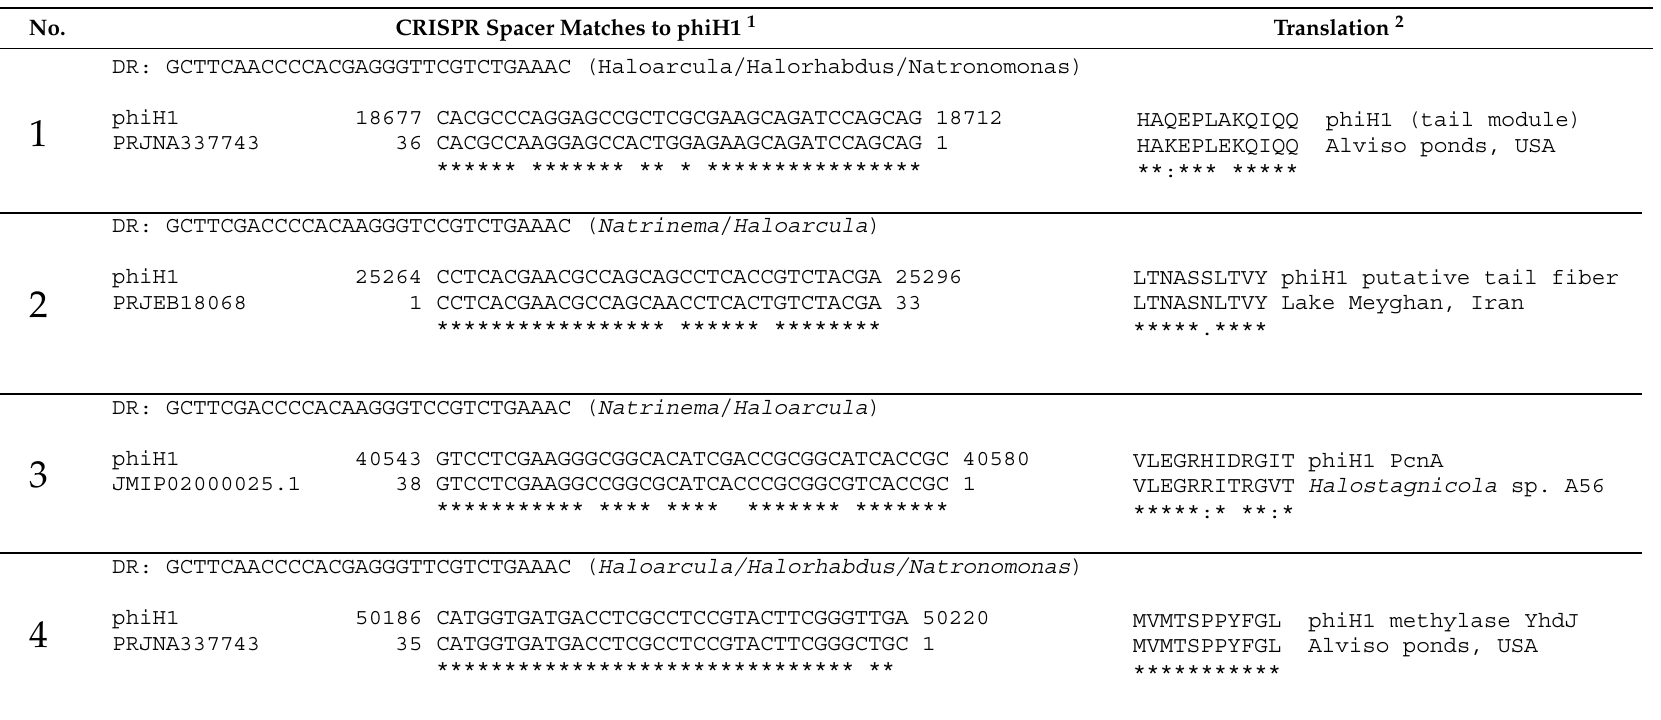
Table 2. CRISPR spacers matching phiH1.